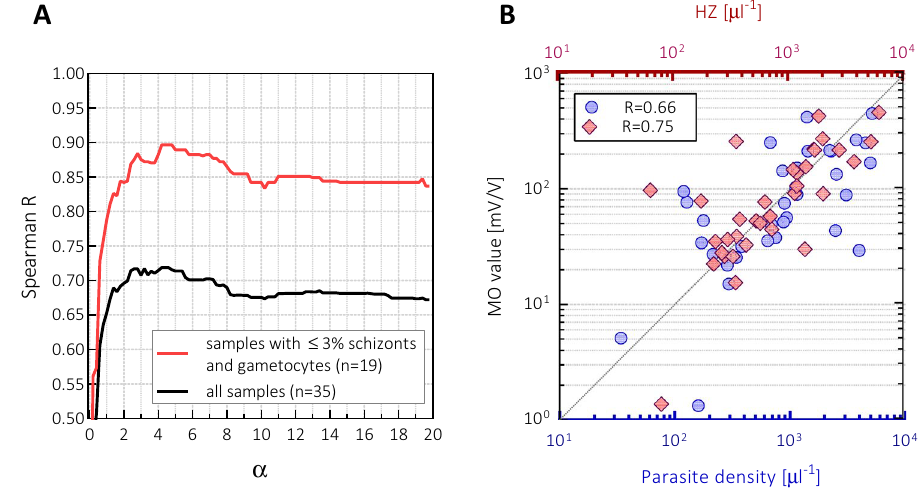
Figure 3. ( A ) The Spearman rank correlation coefficient between the MO values and the estimated hemozoin content, HZ = 1 · Ri + α · T , as the function of α . The red curve shows the correlation coefficient calculated for the subset of samples in which the proportion of schizonts and gametocytes was below 3% (n = 19). The black curve shows the correlation coefficient for the full sample set (n = 35). ( B ) The MO values as the function of parasite density (bottom x-axis, blue circles) and as the function of HZ (top x-axis, red diamonds).The latter was calculated using the value α = 4.5 (determined from the red curve in panel A), and also including the